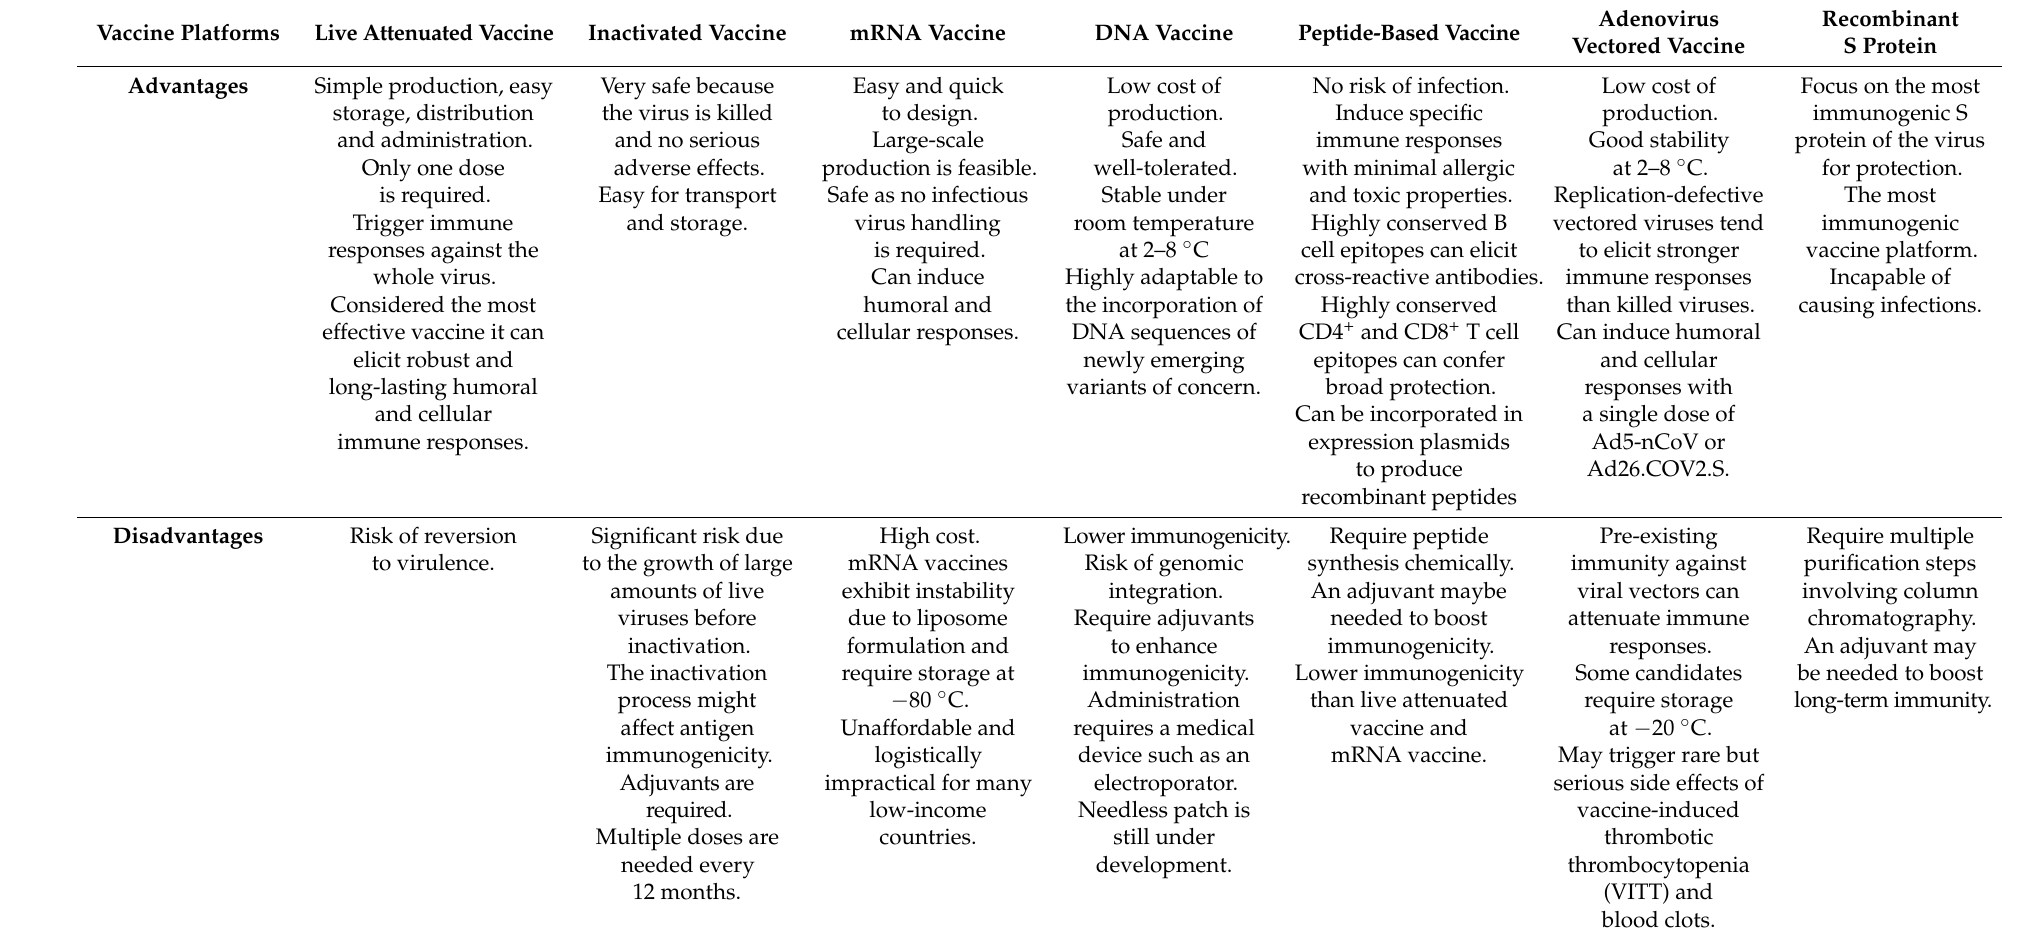
Table 2. Advantages and disadvantages of different SARS-CoV-2 vaccine